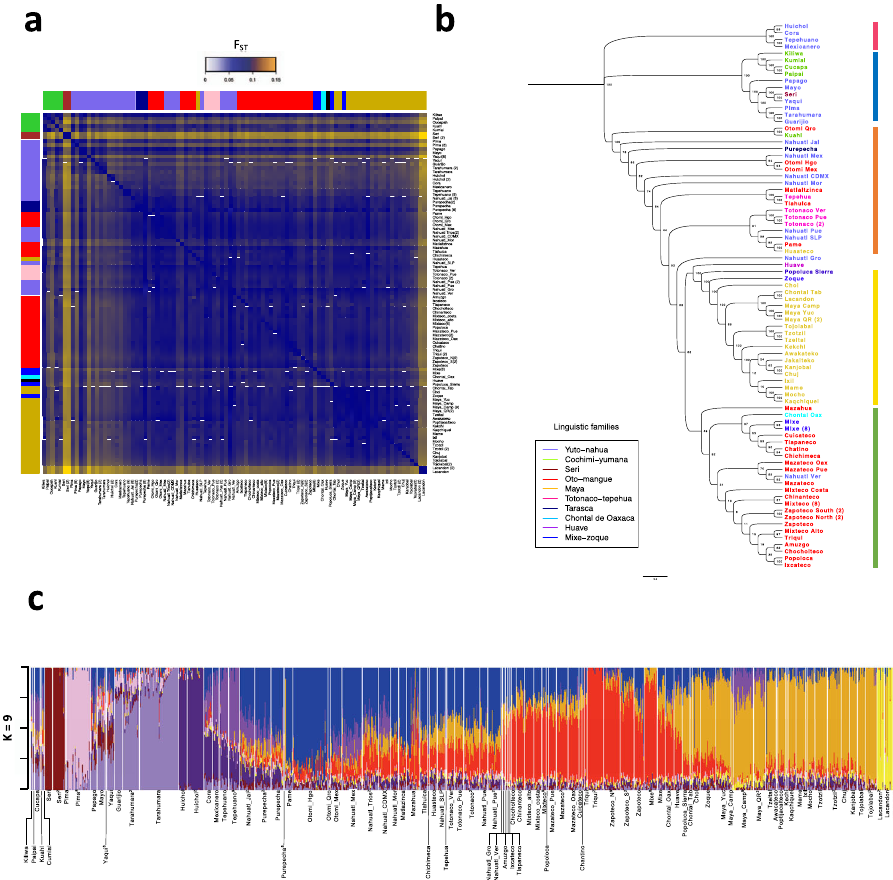
Fig. 2 The genetic diversity of Indigenous groups correlates with their geographic distribution. a Pairwise- F ST matrix for all tested populations. Colored bars represent the linguistic family. b F ST -based neighbor-joining tree showing the correlation with geographic location independent of linguistic classi fi cation (colored names), the numbers above the branches indicate the bootstrap values. Colored vertical lines represent the identi fi ed geographic regions: North (blue), Northwest (red), Central-east (orange), South (green), and Southeast (yellow). c Admixture analysis assuming K = 9 clusters in Mexican Indigenous populations. Superscript numbers are the corresponding